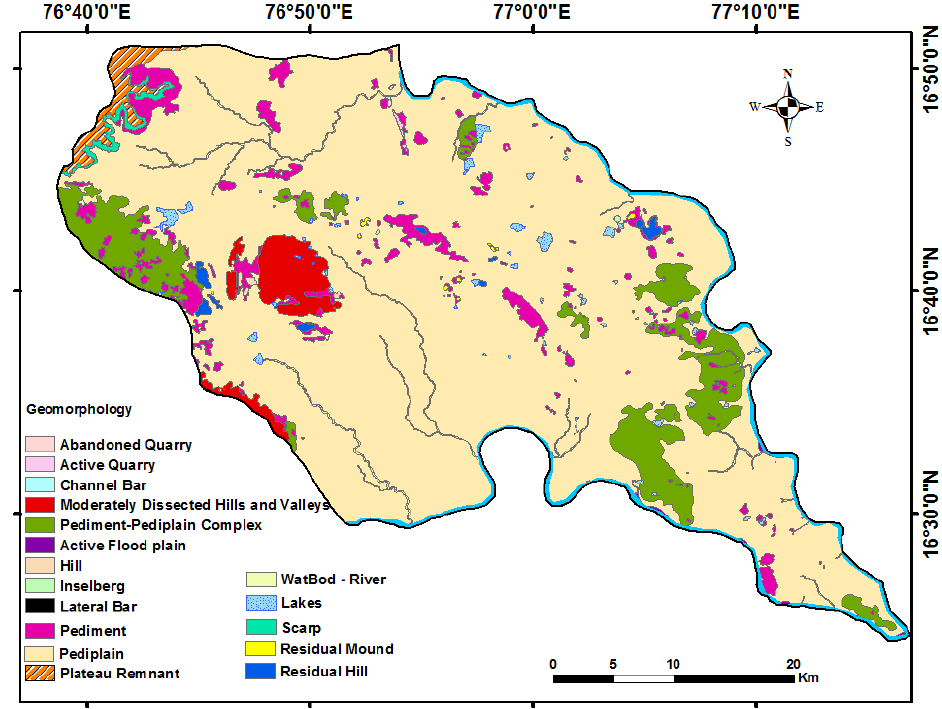
Figure 4. Geomorphology of the study